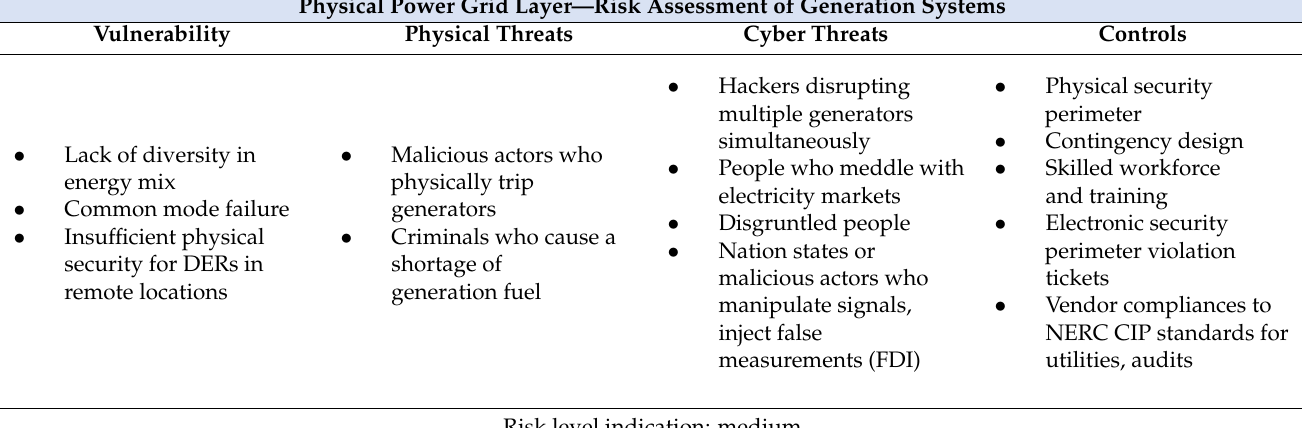
Table 3. Risk assessment of generation systems.